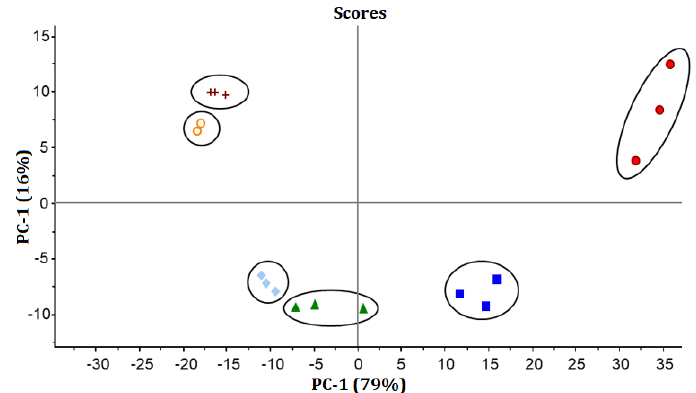
Figure 2. PCA score plot of S. arvensis leaf extracts: water (■), 10% ethanol (●), 30% ethanol (▲), 50% ethanol (♦), 70% ethanol (+), and absolute ethanol